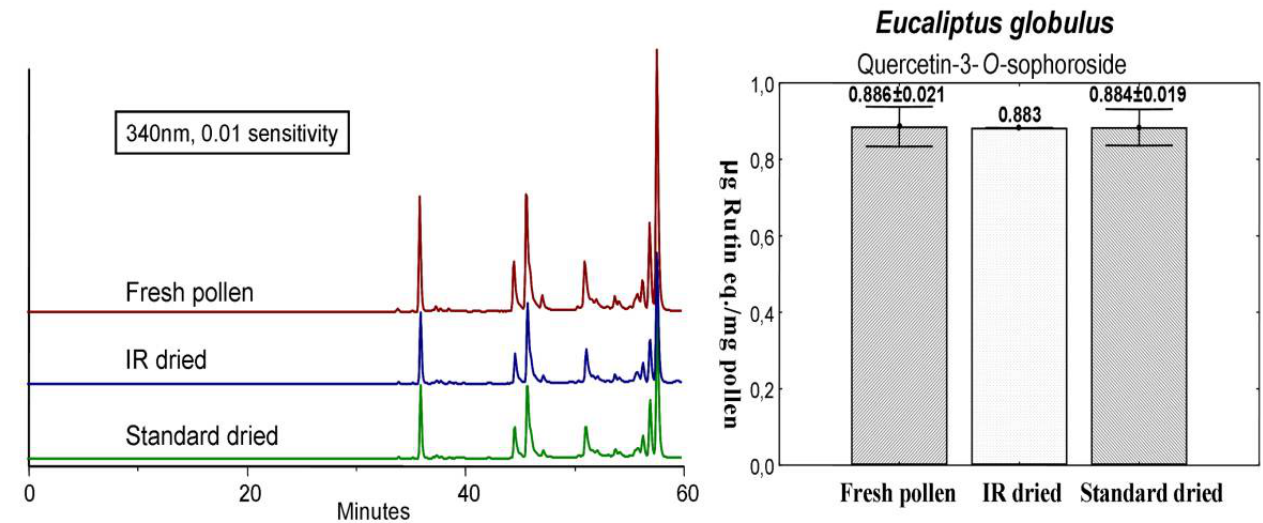
Figure 4. Chromatogram of E. globulus fresh and dried pollen extract and quercetin-3-O-sophoroside quantification, expressed as rutin equivalent mg/g of dry pollen. Results represents means ± SD (n = 3).